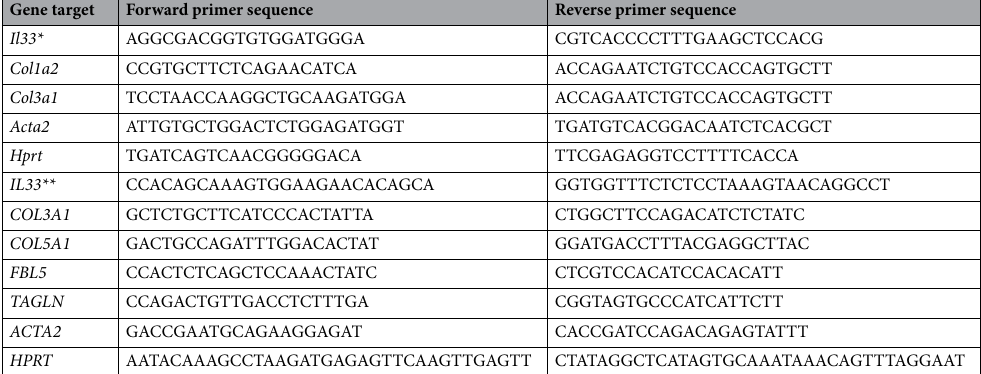
split at a ratio not exceeding 1:3. A minimum of cells from 2 different donors were pooled to reduce biological variation. Gene silencing. Human IL-33 (#4392422) and Silencer Select Negative Control No. 2 siRNA (#4390846 ) were purchased from Thermo Fisher Scientific (Oslo, Norway). Fibroblasts were transfected with 30 nM siRNA using Lipofectamine RNAimax (Invitrogen, Oslo) in Opti-MEM for 12 h followed by a change to serum free fibroblast growth medium, containing IFN-γ (100 ng/ml) and TGF-β (2 ng/ml) for another 12 h before harvest and RNA extraction. RNA extraction and qRT‑PCR. Harvested tissue was stabilized in RNAlater (Life Technologies, Carls- bad, CA) and stored at − 80 °C. Samples were homogenized in RLT buffer from the RNeasy Mini Kit (Qiagen, Norway, Oslo) with 6.35 mm diameter ceramic spheres (MP Biomedicals, Santa Ana, CA) in a bead-milling homogenator (MP Biomedicals FastPrep-24). RNA from these homogenates or from cell cultures, was isolated with the RNeasy Mini Kit according to the manufacturer’s instructions (Qiagen, Oslo, Norway). RNA purifica- tion was performed using an RNase-Free DNAse Set (Qiagen, Oslo, Norway). RNA concentration and quality were assessed with an ND1000 NanoDrop Spectrophotometer (ThermoFisher). Reverse transcription of 1 μg of RNA was performed with SuperScriptIII Reverse Transcriptase cDNA system (Invitrogen), oligo (dT) primers, and dNTPs (GE Healthcare, Oslo), according to manufacturer’s instructions. The PCR reaction consisted of 5 μl of 10-times diluted cDNA in a 20-μl qPCR reaction consisting of 5000 U Hot-Start Taq DNA polymerase (Qia- gen, Oslo, Norway), dNTP (GE Healthcare), 20 × EvaGreen (Biotium), and the individual primer sets (Table 1). Quantitative RT-PCR was performed with the Stratagene Mx3005P instrument and Stratagene MxPro software (Agilent Technologies, Santa Clara, CA) with the following program: hot start at 95 °C for 15 min, amplification 40 cycles at 95 °C for 30 s, 60 °C for 30 s, 72 °C for 30 s, melting 95 °C for 1 min, 57 °C for 30 s, 95 °C for 30 s, 40 °C for 10 s. Data were analyzed according to the comparative C T method (2 −ΔΔCT method) of Schmittgen and Livak 18 , where the internal control relative to constitutive gene expression was provided by hprt gene expression (2 −ΔCT ), and where indicated, these results was further normalized to an experimental control (2 −ΔΔCT ), in UUO experiments by comparison to sham-operated mice and in cell cultures using untreated cells.